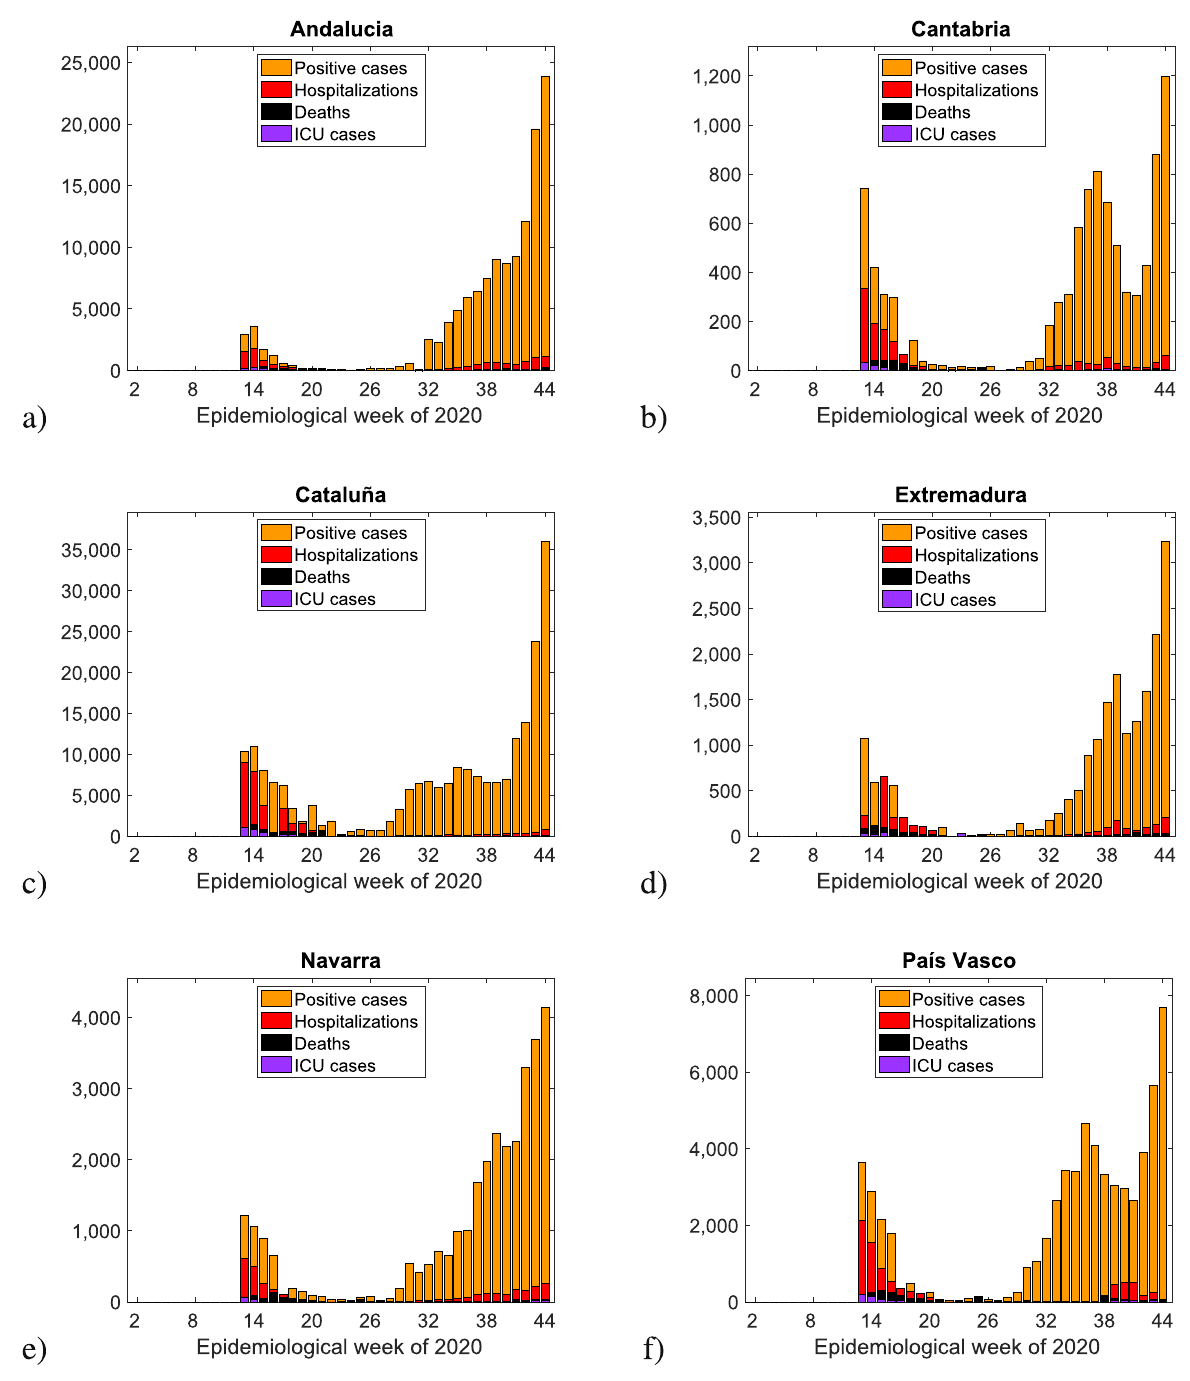
Figure 5. Weekly positive cases, hospitalizations, ICU cases, and deaths in various Spanish autonomous communities until the end of epidemiological week 44 (October 31) of